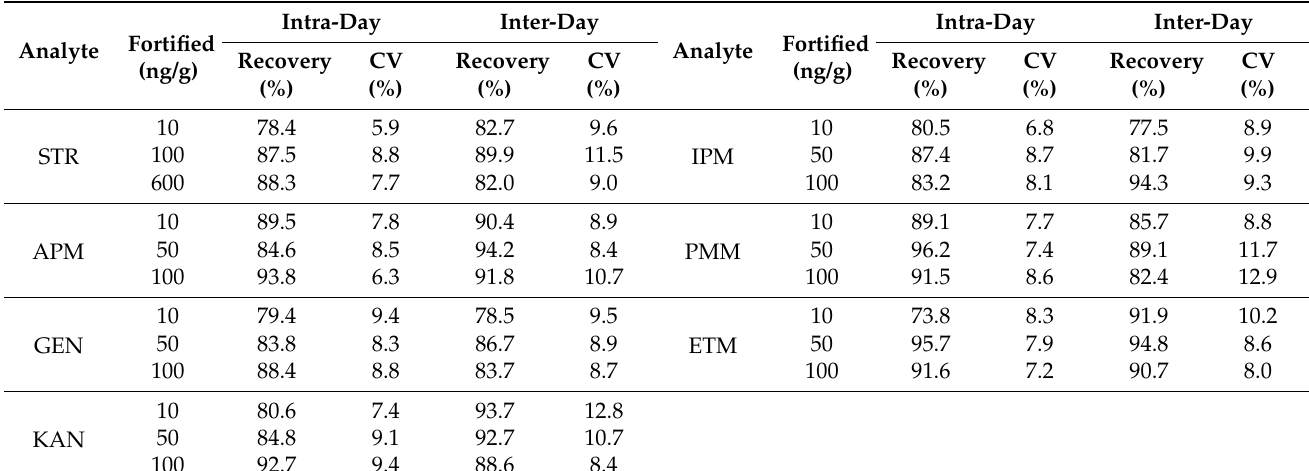
Table 2. Recoveries from AG-fortified blank pork samples ( n =6).